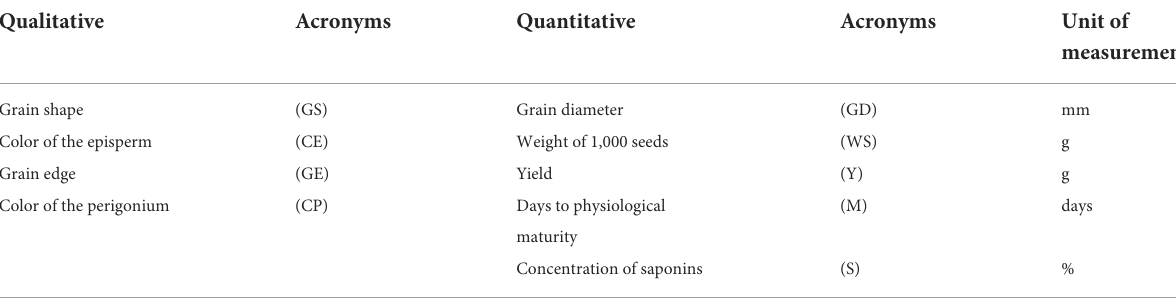
TABLE 2 Morphoagronomic descriptors used for the characterization of quinoa accessions. Qualitative Acronyms Quantitative Acronyms Unit of